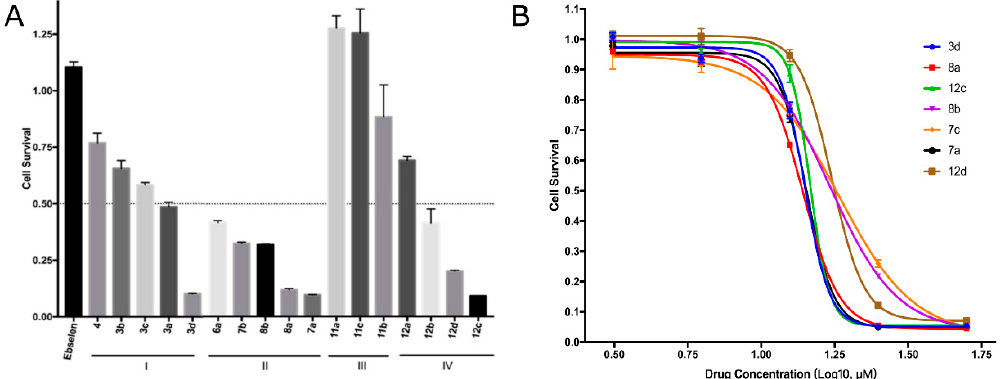
Figure 2. Effects of the tested compounds on cell viability of EBC-1 cancer cell line. ( A ) Percentage of viable cells (EBC-1) after 72 h exposure to the compounds at a concentration of 25 μ M compared to the compound-free control received an equal volume of DMSO (100% viability). Each value was calculated from two independent experiments. The competitive inhibitory activity was expressed as an inhibition rate. ( B ) Growth inhibition effect of compounds 3d , 7a , 7b , 8a , 8b , 12c and 12d on EBC-1 cells. EBC-1 cells were seeded into 96-well cell culture plates and allowed to grow overnight. Thereafter, cells were treated with vehicle control (DMSO) or the compounds at the indicated concentration for 72 h. After treatment, 10 μ L resazurin were added to the culture medium. After incubation at 37 °C for 5 h, fluorescence intensity was measured at a 530 nm excitation wavelength and a 590 nm emission wavelength using a Synergy HT photometer.